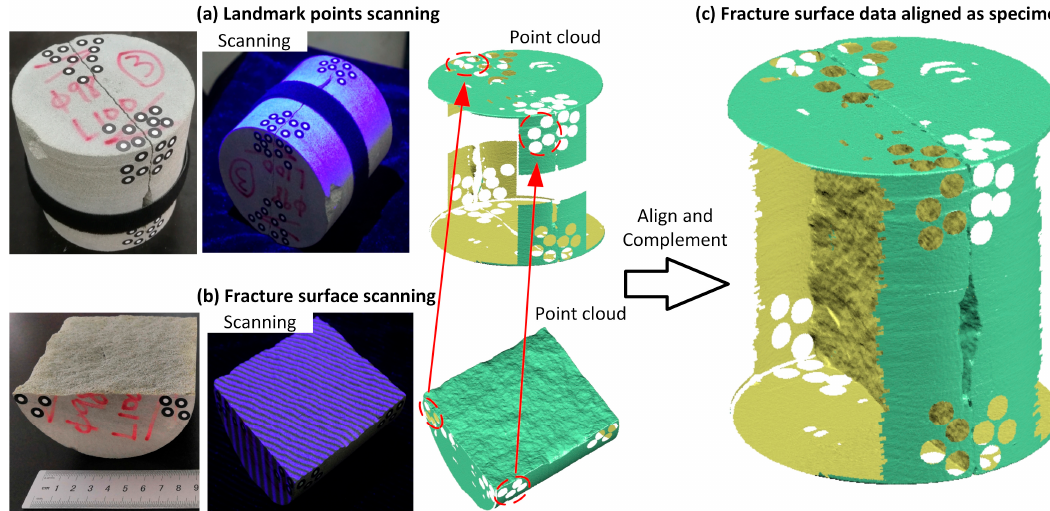
Figure 3. Fracture surface scanning and aligning process.